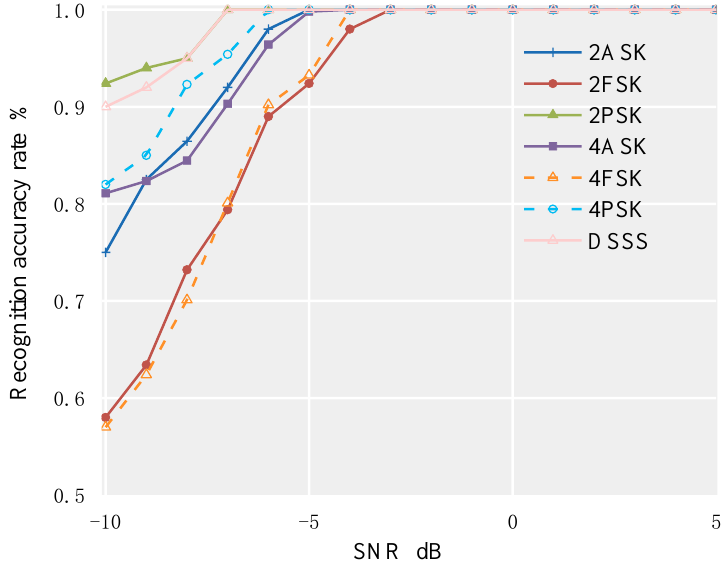
Figure 8. Figure 8. Recognition rate of seven modulation signals based on AOA – RF algorithm in AWGN environment.